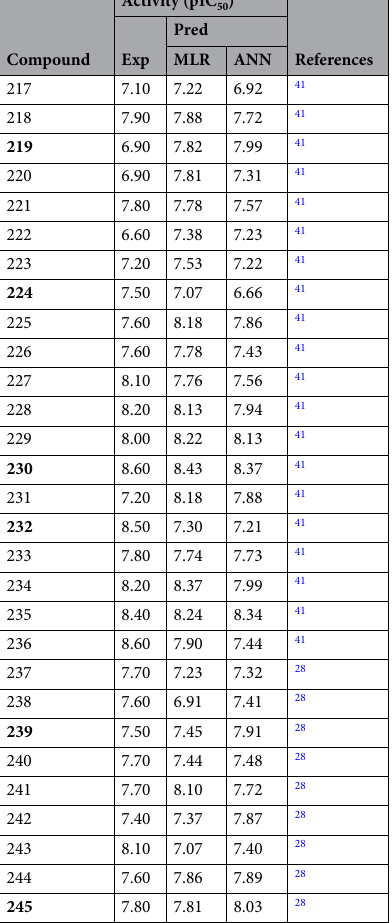
Table 6. Experimental pIC 50 values for 245 PI3Kγ inhibitors used as training and test sets and corresponding predicted values for them based on the MLR and ANN methods. a Bold cases used as a test